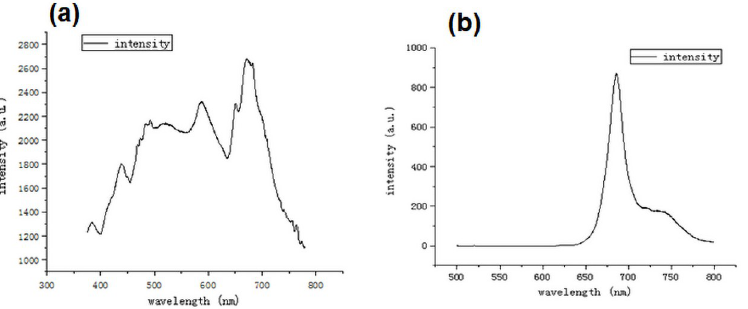
Fig 8. (a) Emission spectrum and (b) absorbance spectrum of Chlorella sp. Emission measurement under pigment extraction excited at 512 nm (ex: 512 nm). The peak is at 671 nm, 587 nm, 492 nm and 438 nm. This describes the intensity difference between carotenoid and chlorophyll spectral